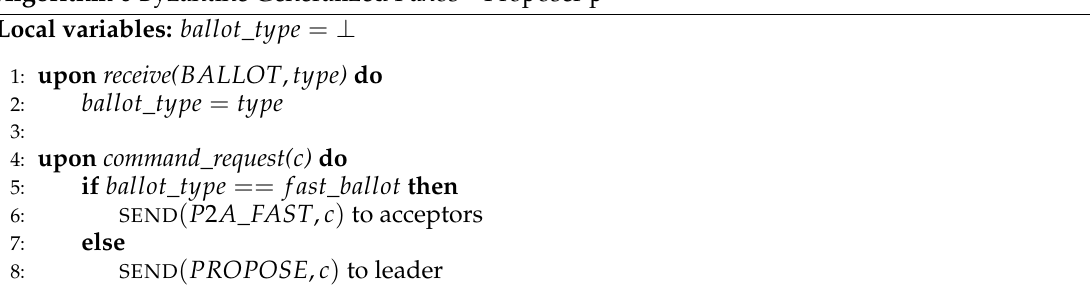
Algorithm 6 Byzantine Generalized Paxos—Proposer